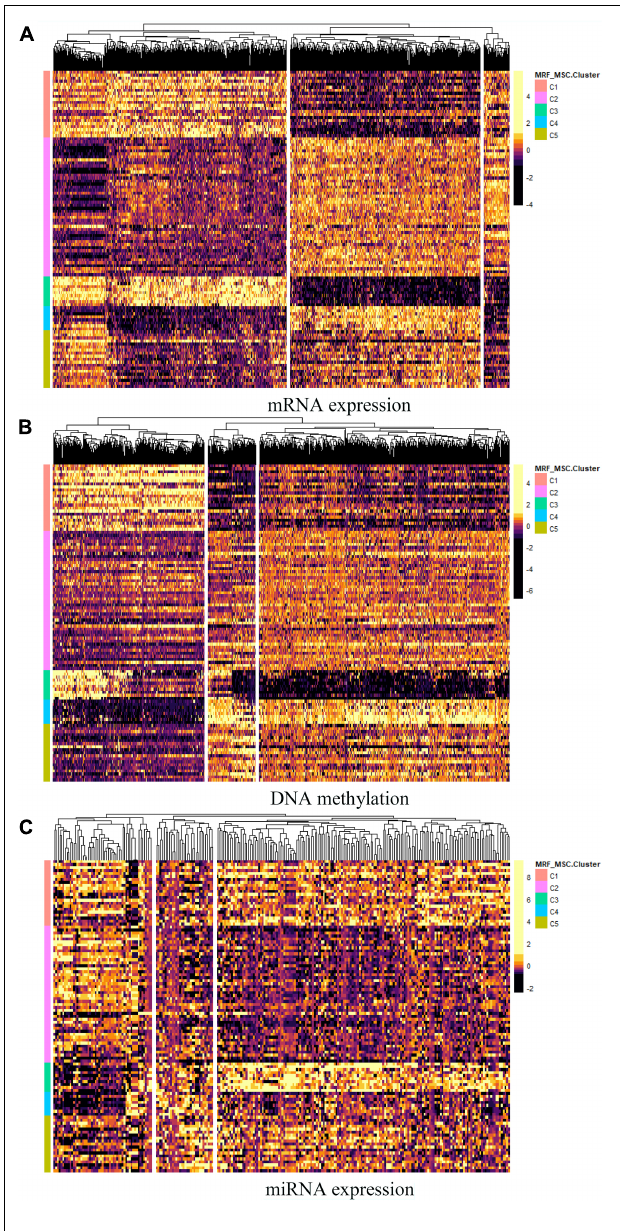
FIGURE 6 | The heatmap of differentially expressed genes in (A) mRNA expression, (B) DNA methylation, and (C) miRNA expression